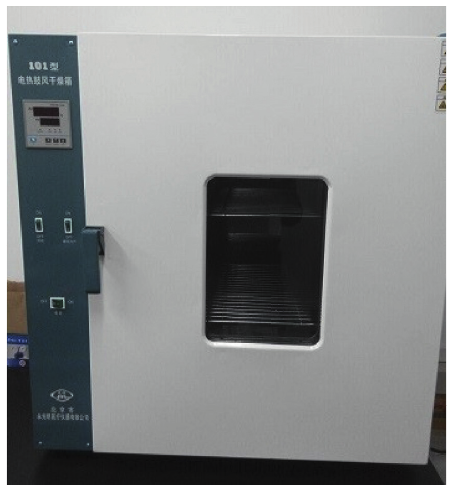
Figure 2: The electrothermal blowing dry box.